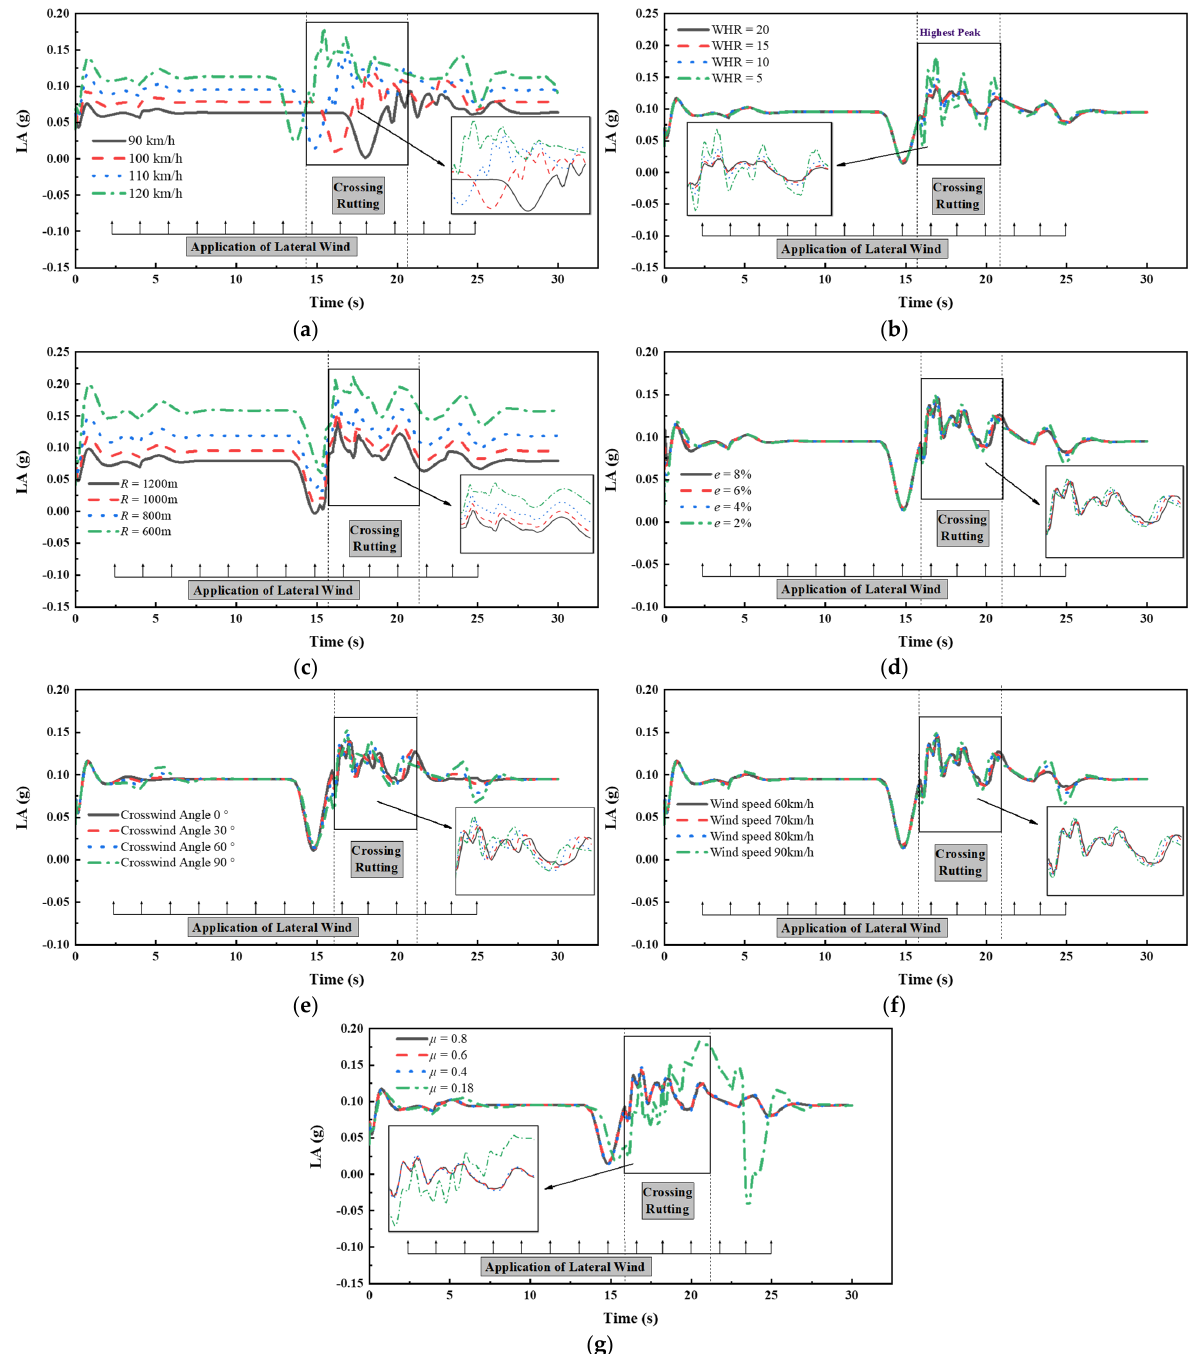
Figure 8. Change of LA over time under various driving conditions: ( a ) Vehicle speed; ( b ) WHR of the rutting; ( c ) Radius of circular curve; ( d ) Superelevation; ( e ) Crosswind angle; ( f ) Wind speed; ( g ) Friction coefficient between road & tire.